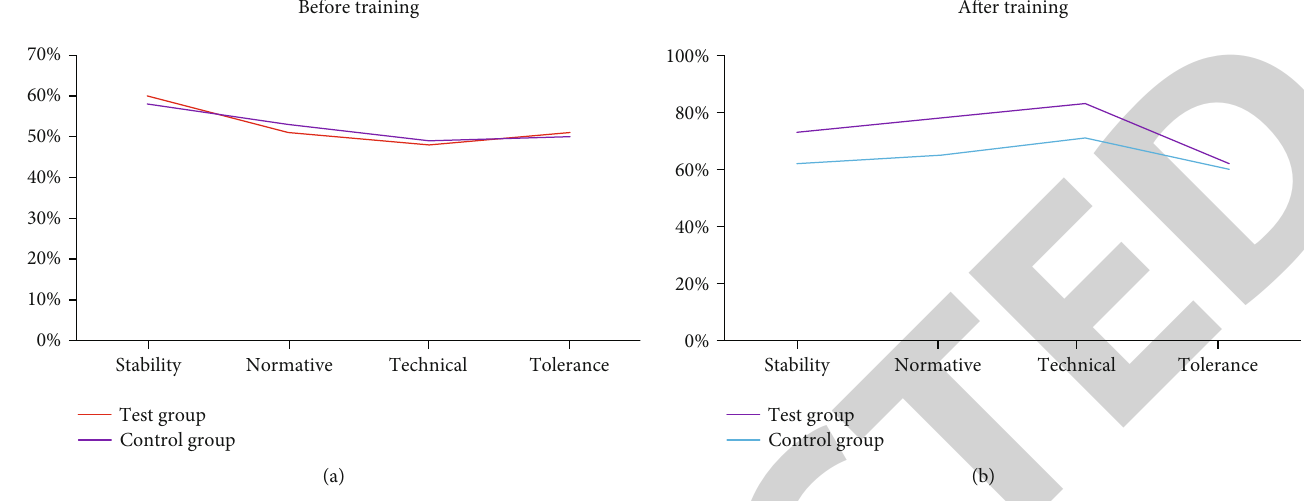
Figure 9: Comparison of various indicators before and after the athletes ’